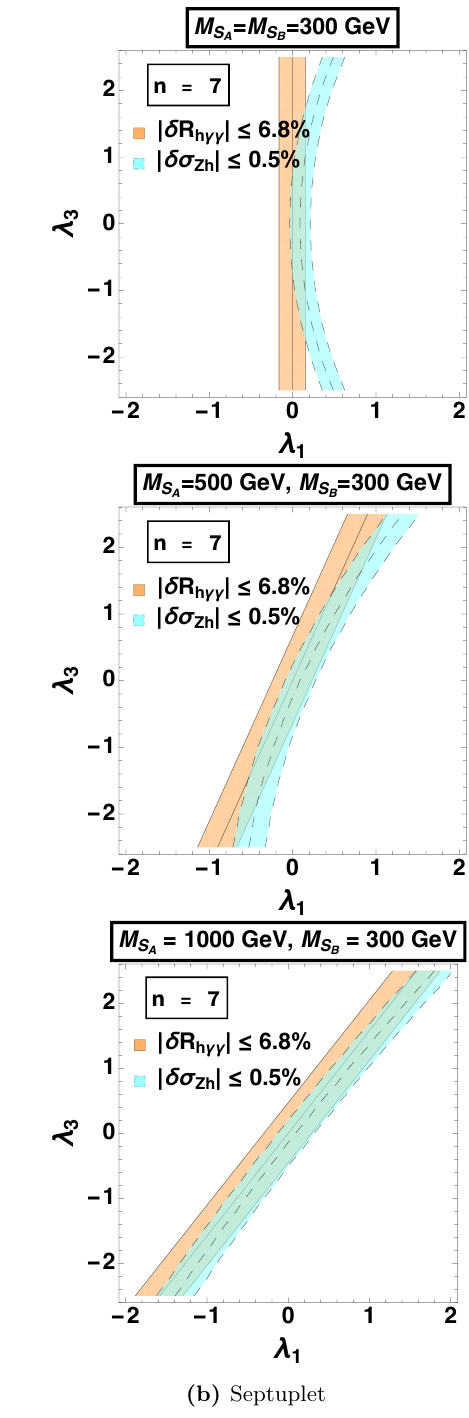
Figure 10. Contour comparison for | δσ Zh | ≤ 0 . 5% (cyan band outlined with dashed lines) and | δR hγγ | ≤ 6 . 8% (orange band outlined with solid lines) for quintuplet and septuplet with fixed values of the physical masses ( M ) = (300 , 300) , (500 , 300) , (1000 , 300) GeV , S A , M S B